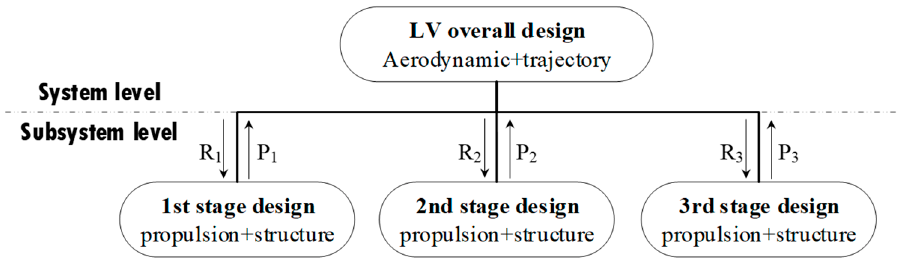
Figure 6. Typical HRM-powered LV configuration.